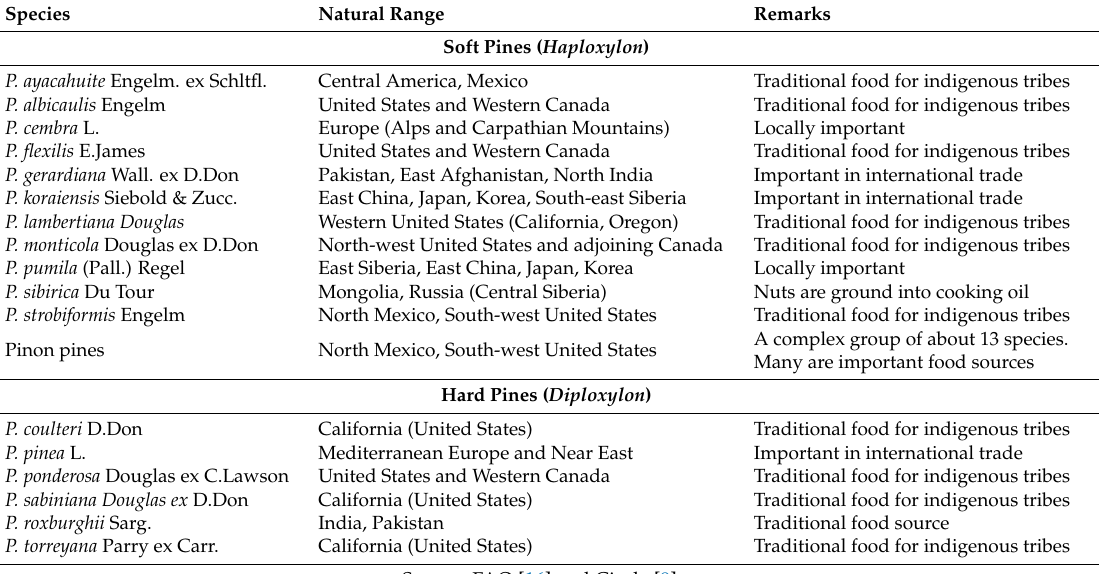
Table 1. Comestible species of pine nuts in the